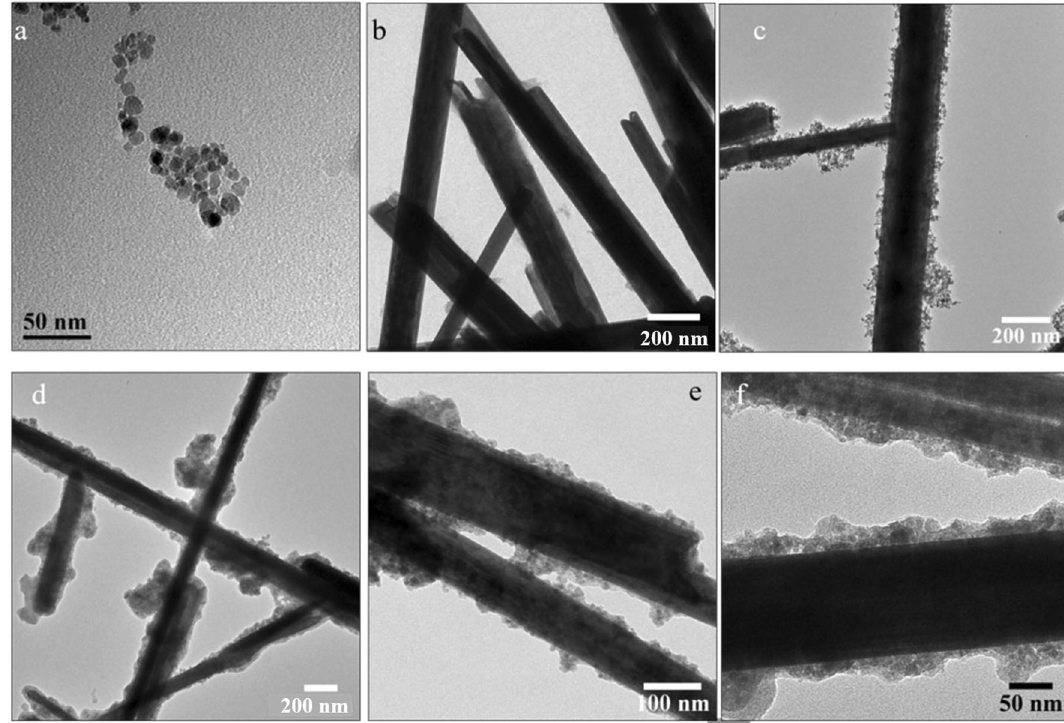
Figure 2. TEM images of ( a ) CM NPs; ( b ) WS 2 -NTs; ( c ) WS 2 -NT-CM; ( d – f ) WS 2